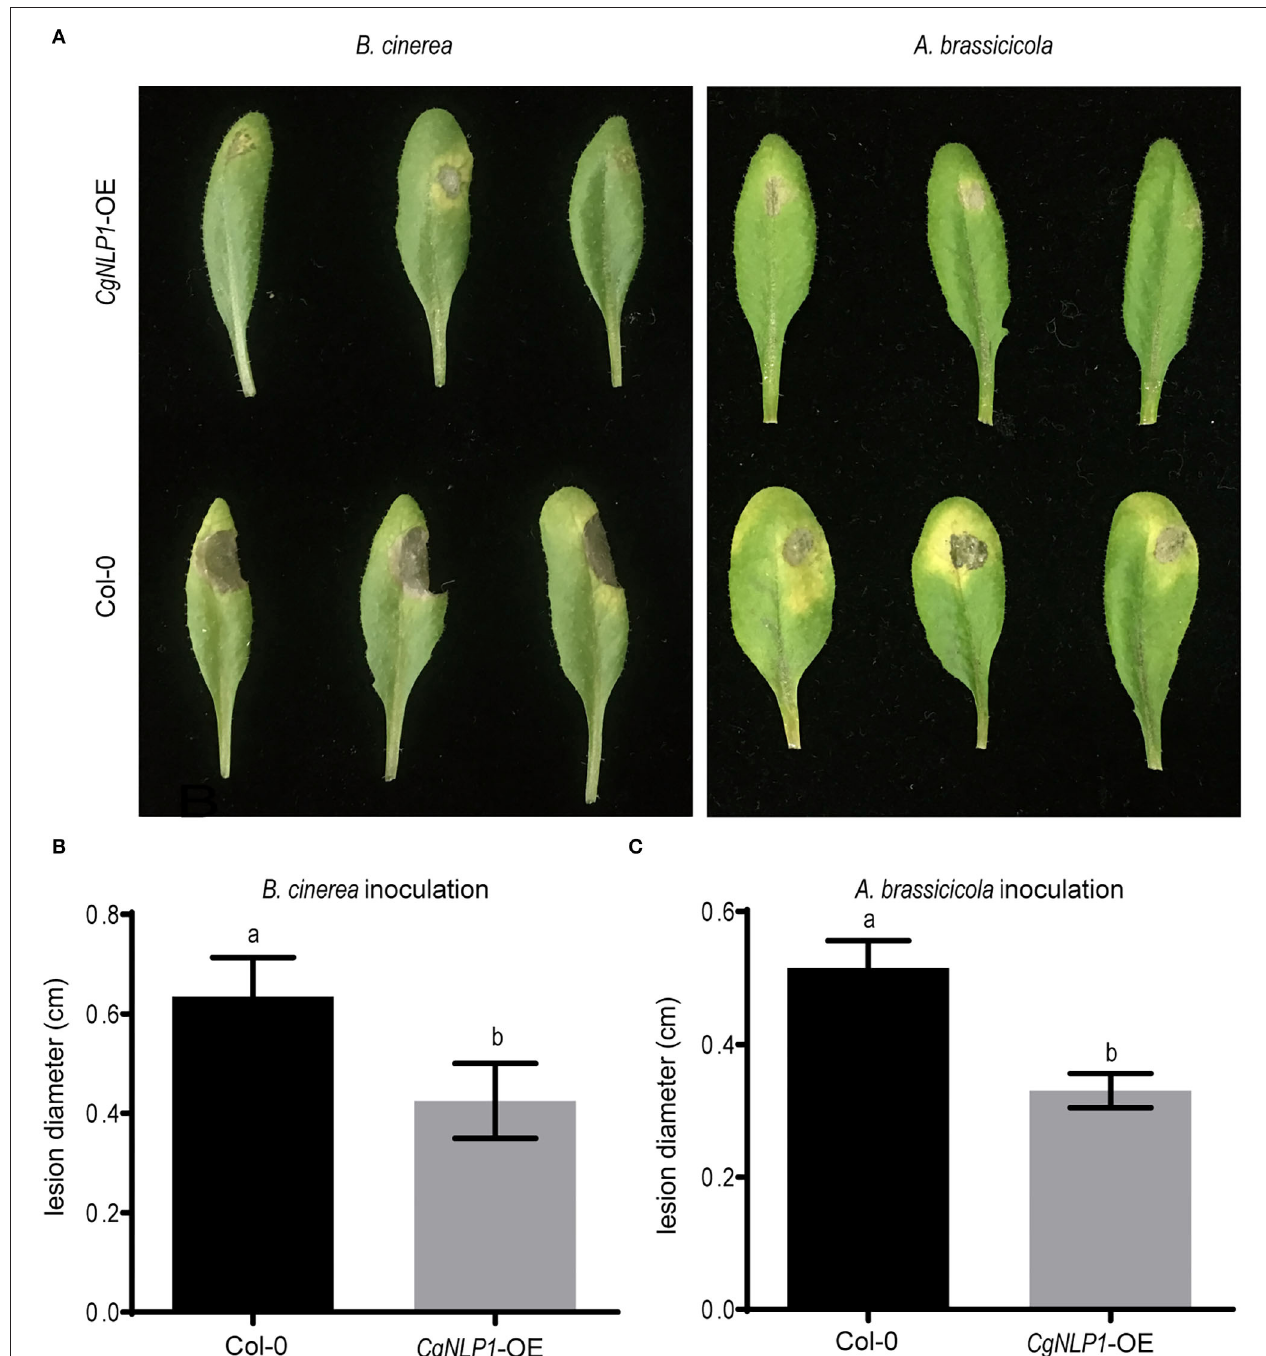
FIGURE 4 | Overexpression of CgNLP1 in Arabidopsis enhanced the resistance to B. cinerea and Alternaria brassicicola . (A) Disease symptoms on Arabidopsis lines overexpressing CgNLP1 ( CgNLP1 -OE) and WT (Col-0) at 3 days of post-inoculated with B. cinerea and A. brassicicola , respectively. (B,C) Statistical analysis of lesion diameter on CgNLP1-OE and Col-0 after inoculation with B. cinerea and A. brassicicola. Data are shown as the means ± SD from three independent experiments, and columns with different letters indicate a significant difference ( P < 0.05).